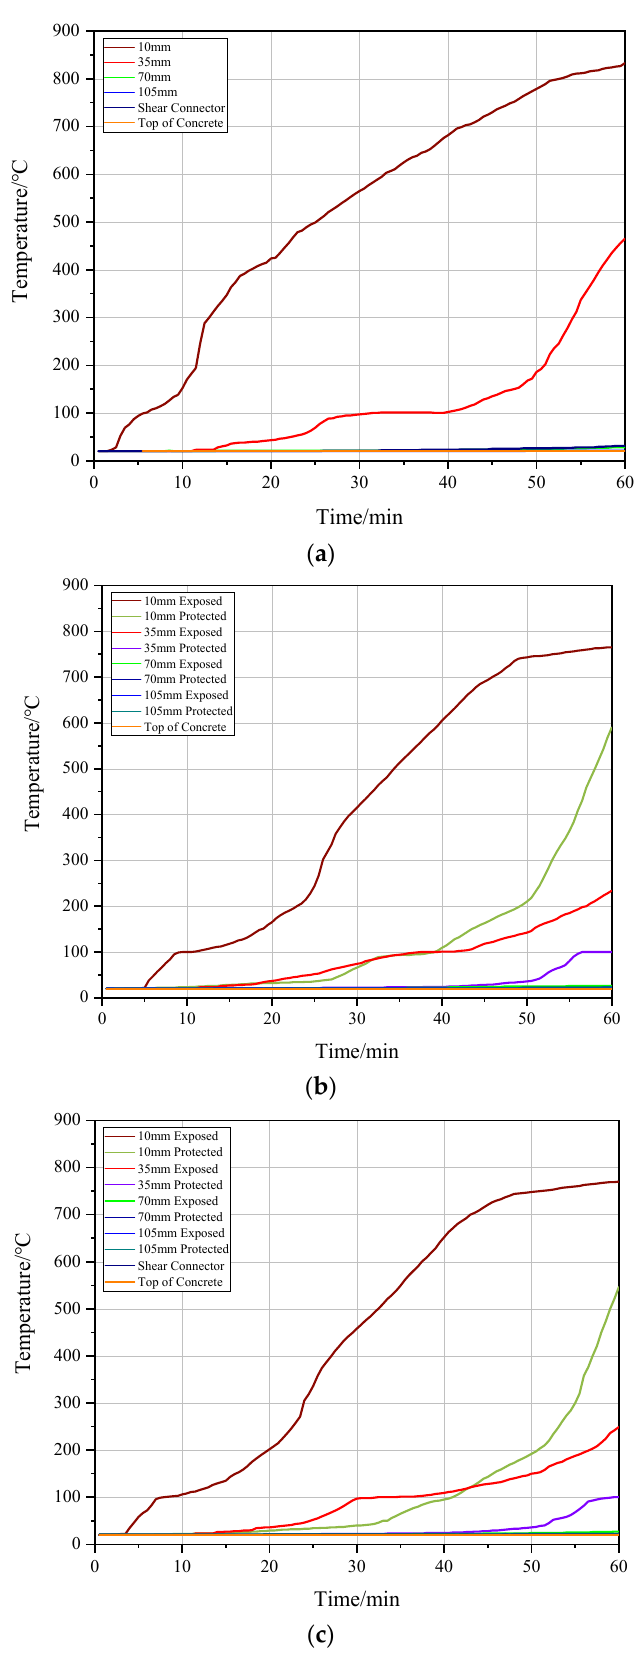
Figure 9. Temperature–time curves of the TCC boards under fire: ( a ) TCC1; ( b ) TCG2; and ( c ) TCG3.